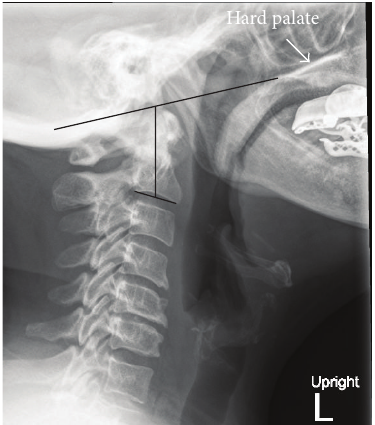
Figure 4: Clark station in the sagittal plane, divided into three equal parts (stations), and determined by the level at which the anterior arch of C1 ( outlined ) falls.